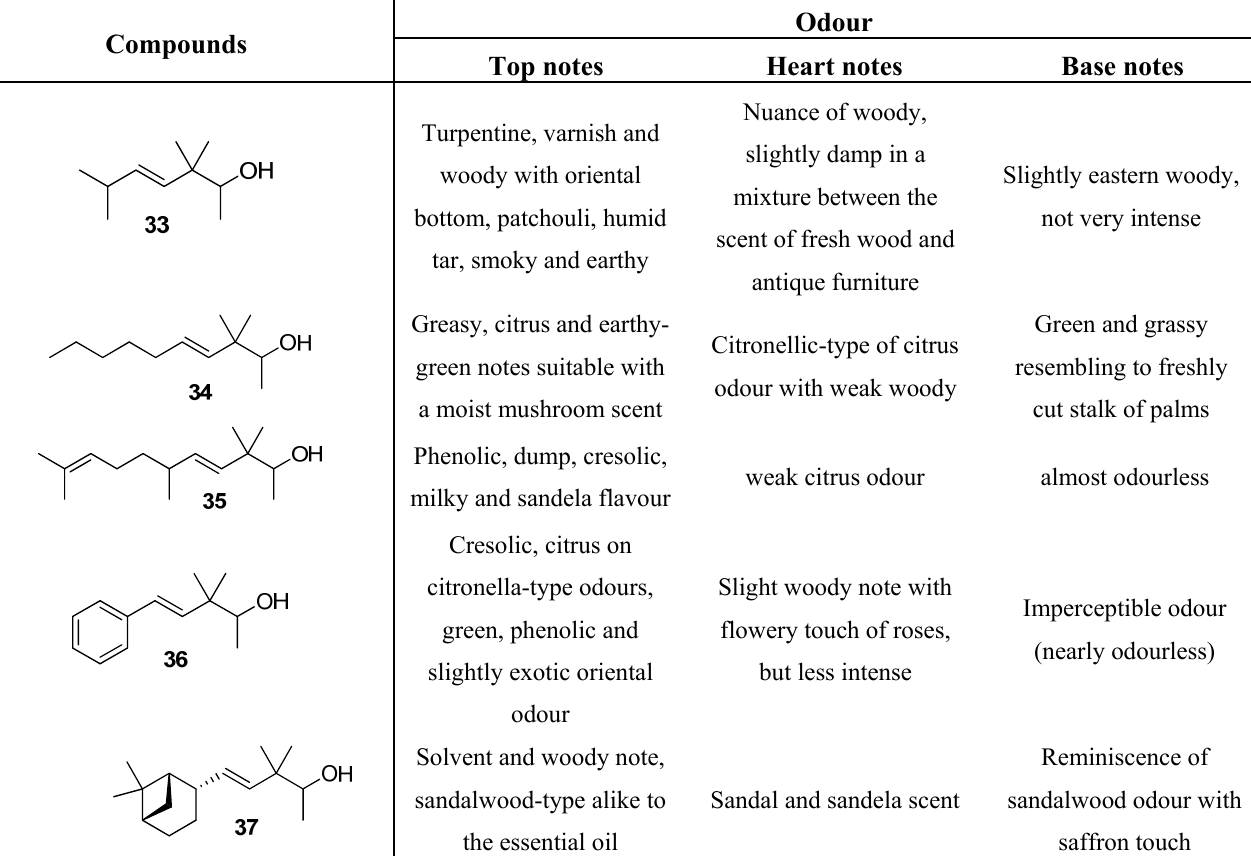
Table 2. Odour evaluation of alcohols 33 – 37 using a GC fitted with sniffing port.